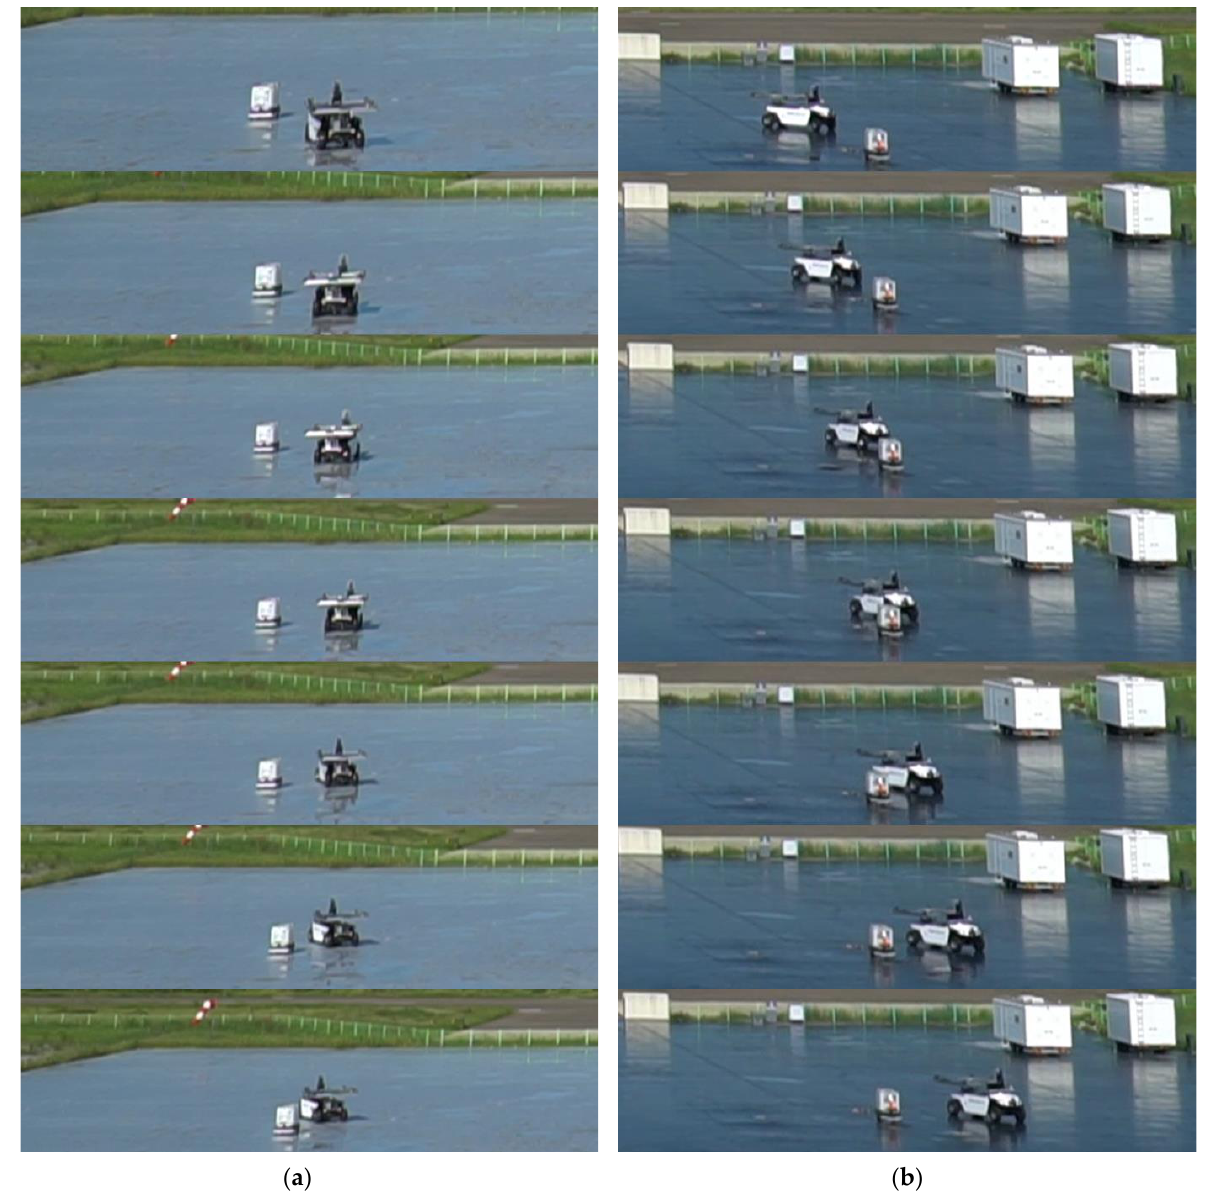
Figure 17. Obstacle avoidance during operation of multiple UGVs/UAVs: ( a ) UGV #1; ( b ) UGV #2.